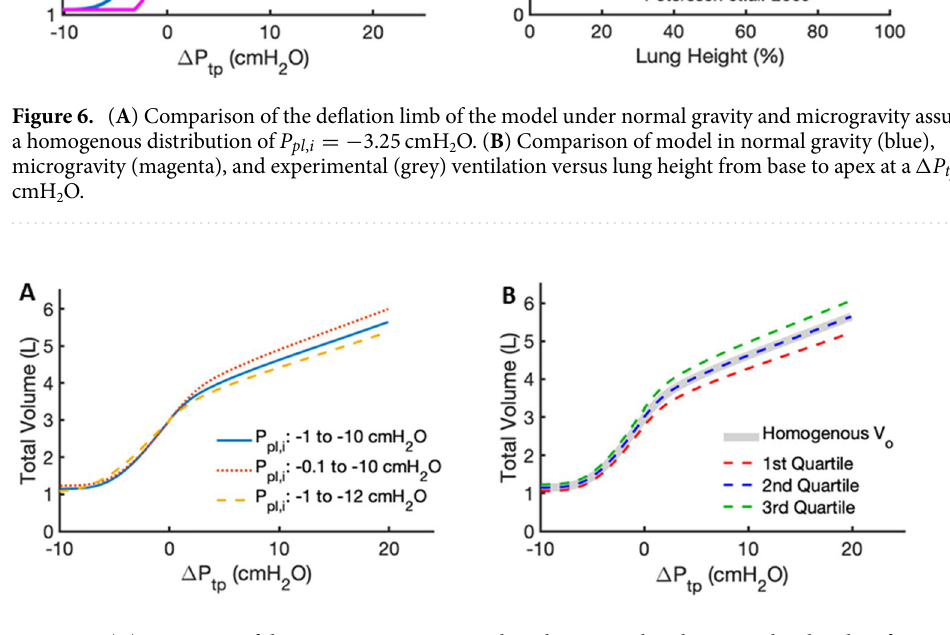
Figure 7. ( A ) Sensitivity of the P–V curve to various pleural pressure distributions. Blue: baseline from − 1 cmH 2 O at the base to − 10 cmH 2 O at the apex; red dotted: from − 0.1 cmH 2 O at the base to − 10 cmH 2 O at the apex; orange dashed: from − 1 cmH 2 O at the base to − 12 cmH 2 O at the apex. ( B ) Sensitivity of the P–V curve to random heterogeneity in alveolar volume V 0